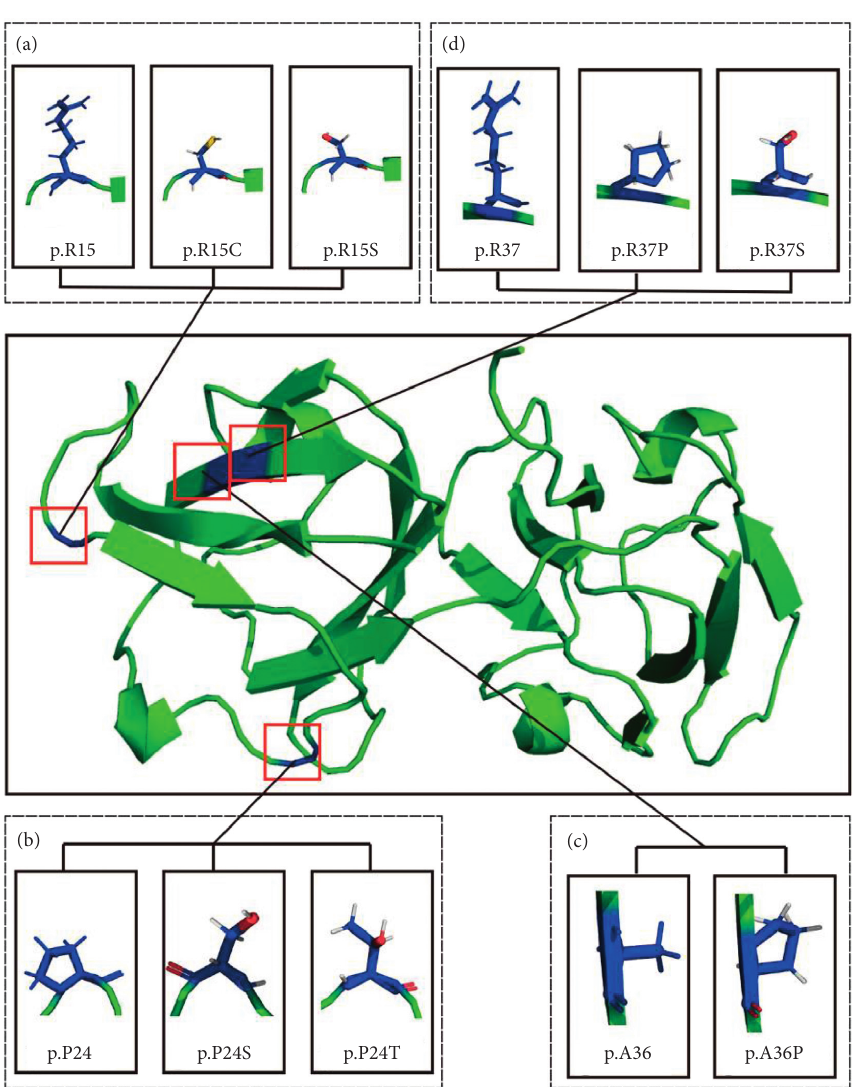
Figure 4: The 3D conformation of seven reported pathogenic mutation sites located in the first “Greek Key” module domain of CRYGD , as predicted by modeling software. (a) The 3D conformation of the wild type CRYGD 15th amino acid arginine and mutant cysteine and serine. (b) The 3D conformation of the wild type CRYGD 24th amino acid proline and the mutant threonine and serine. (c) The 3D conformation of the wild type CRYGD 36th amino acid alanine and the mutant Proline. (d) The 3D conformation of the wild type CRYGD 37th amino acid arginine and mutant serine and proline. 3D,